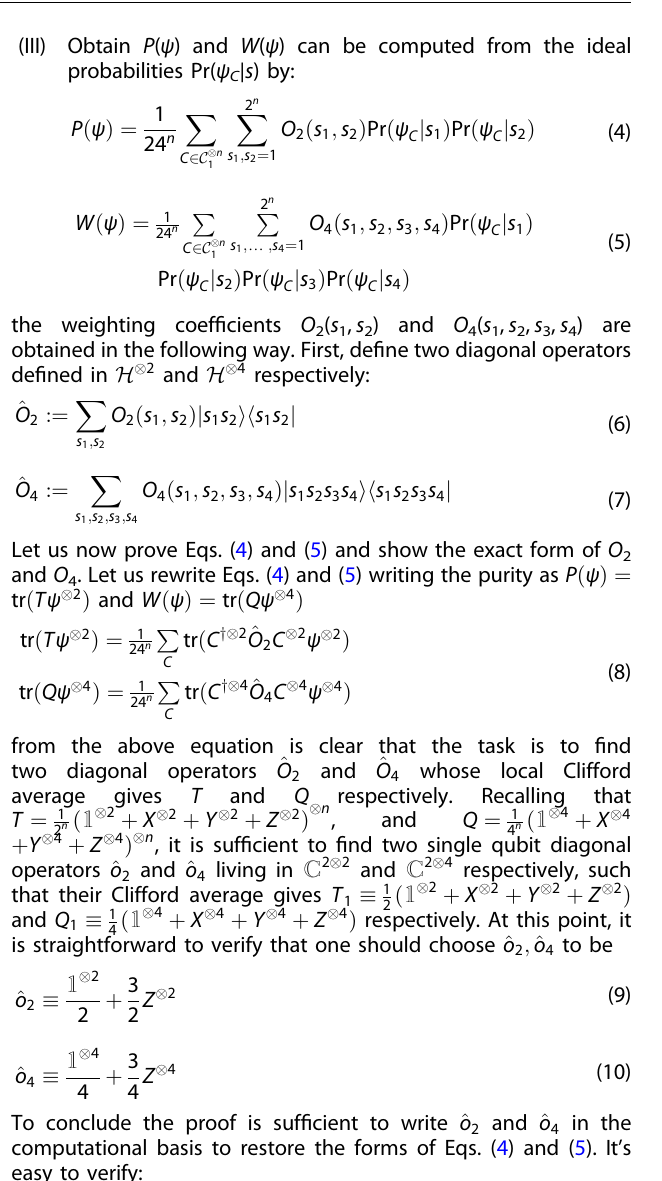
ffiffiffi p d Þ , the variance is Var ½ number of resources to estimate the purity up to an error ϵ ffiffiffiffiffi p scales as Oð ϵ (cid:2) 2 d 3 Þ .